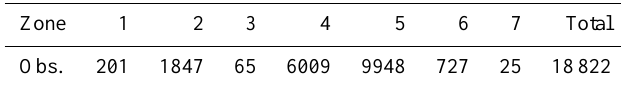
Fig. 9. (a) Schematic representation of the defined zones, and (b) morphological features of the study area. Figure 9a) Schematic representation of the defined seismic zones; b) Morphological features 13 of the study area. 14 Table 6. The number of seismic events in each seismic